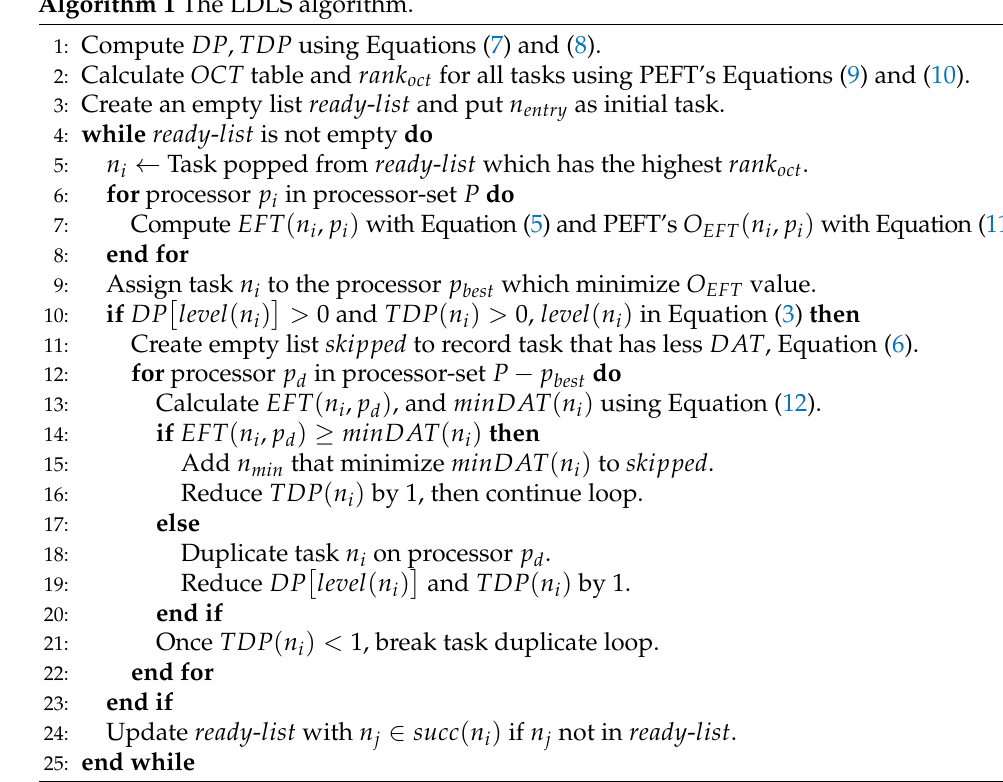
Algorithm 1 The LDLS